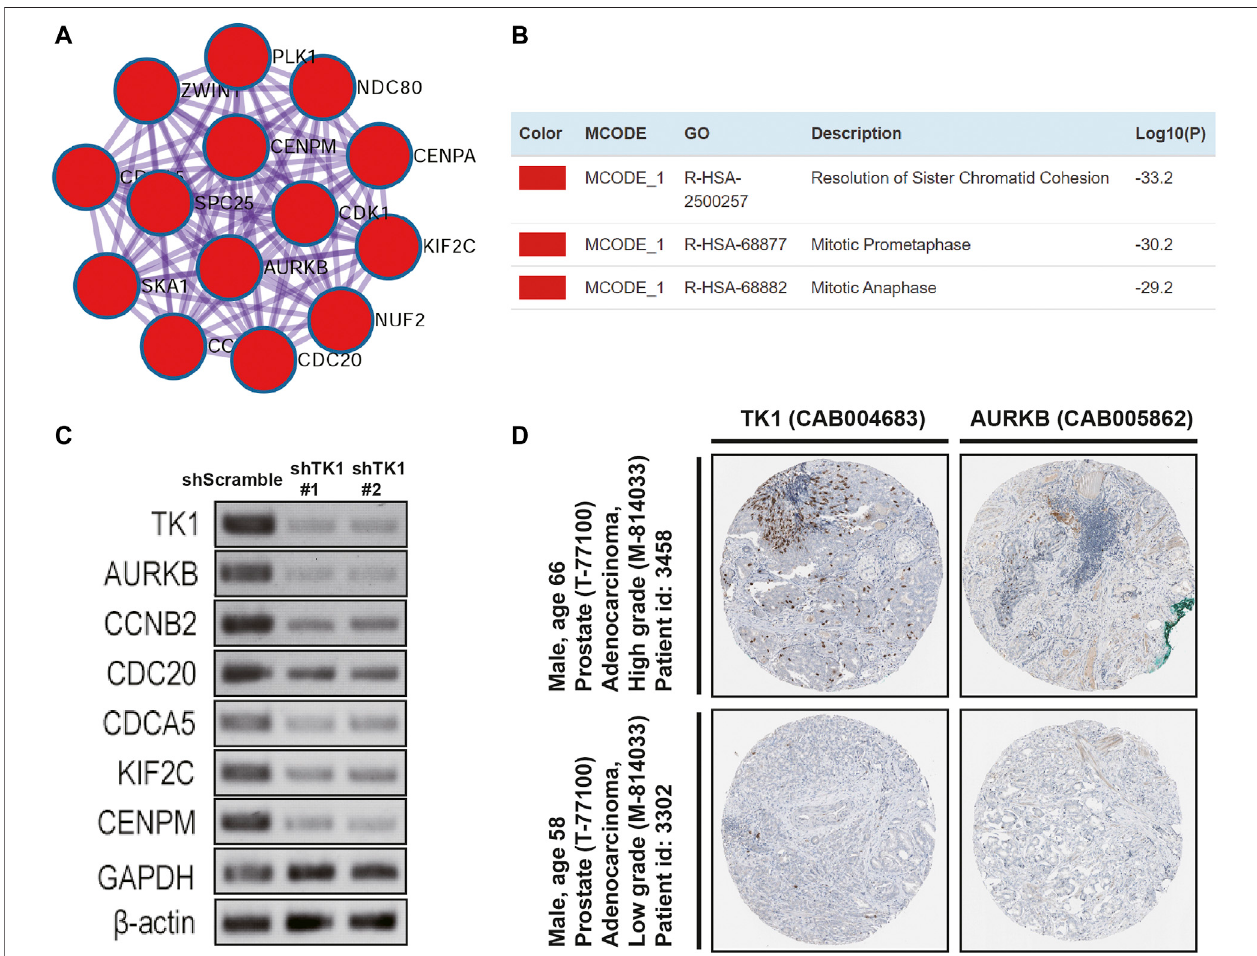
FIGURE 4 | Protein networks and the correlation between TK1 and the hub genes. (A,B) Molecular Complex Detection (MCODE) components of the hub genes. (C) The expression of serval hub genes was down-regulated in the TK1-silencing cells veri fi ed by RT-PCR. (D) TK1 and AURKB protein expression showed by immunohistochemical staining in the same high-grade and low-grade patient. The pictures were taken from the Human Protein Atlas dataset.